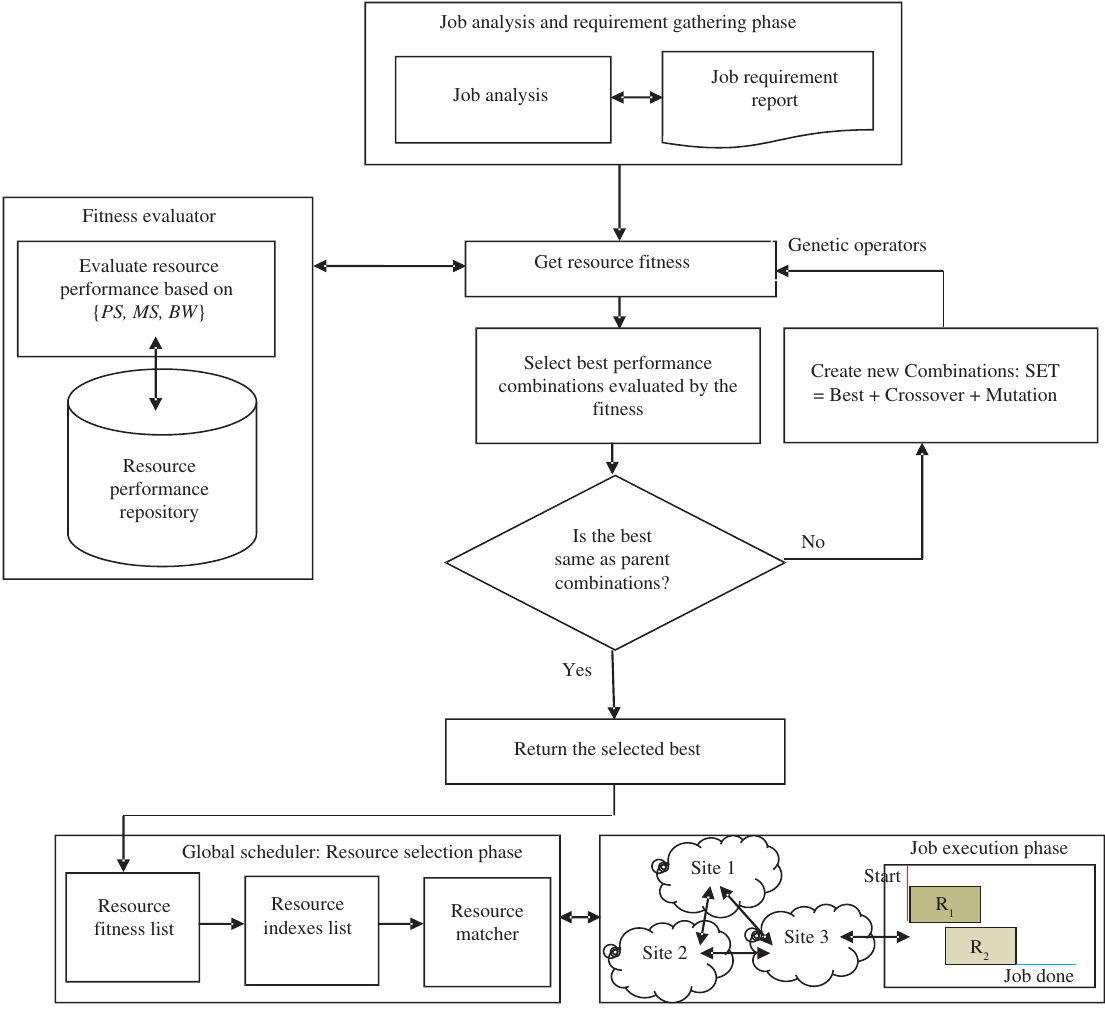
Figure 1: Optimization Algorithm